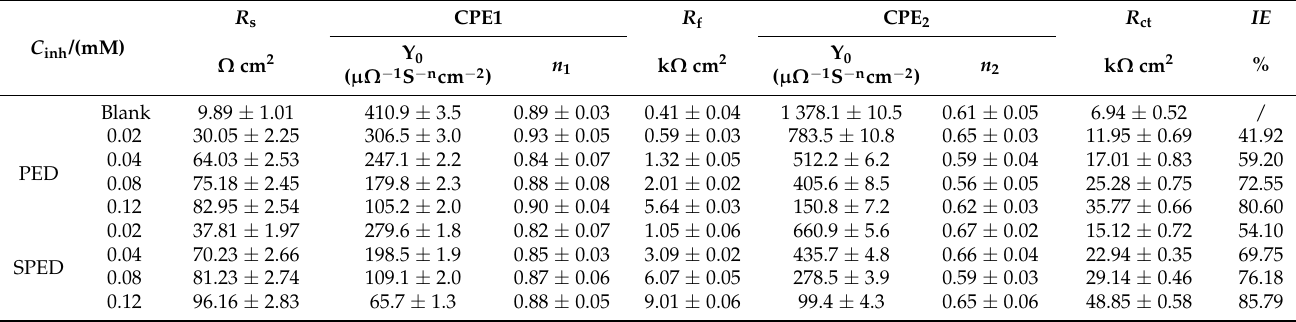
Table 2. EIS parameters of reinforced steel in SCP solution with perimidine derivatives.